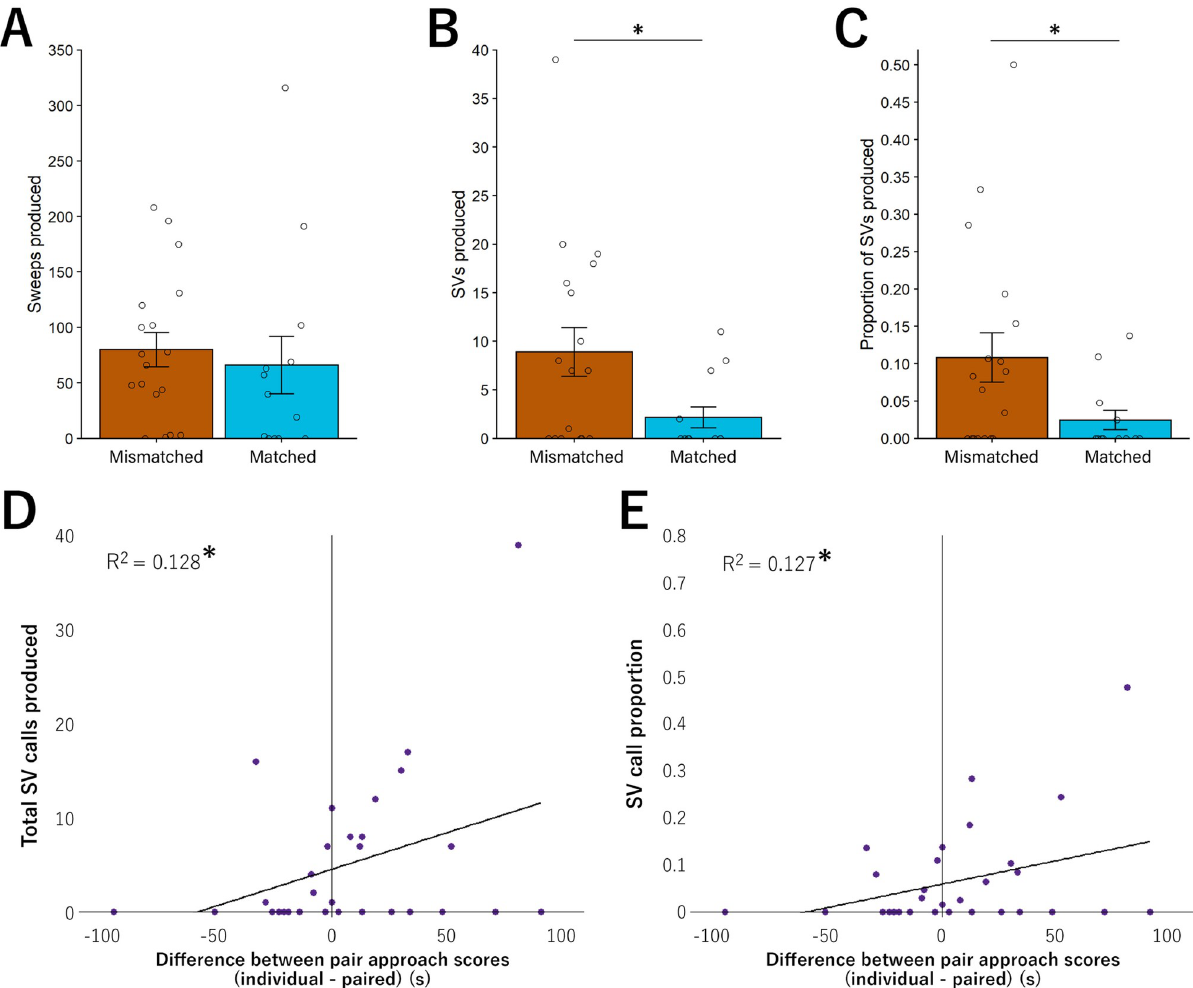
Fig 4. USVs correlated with behavioral coordination. A . Total number of sweeps were similar between mismatched and matched pairs B . Total number of SV calls increased in mismatched pairs compared to all other groups. C . The proportion of SV calls as a function of total calls was greater in mismatched pairs compared to matched pairs. D . Pairs with greater similarity in post-pairing approach scores produced more SVs as a dyad. Pairs that became more similar (pre-pairing approach score difference—post-pairing approach score difference) as denoted by positive numbers on the x-axis, produced more total SV calls as well as E . a significantly greater proportion of SV calls to total USV calls produced ( � = p < 0.05). Bar graphs represent Mean +/-